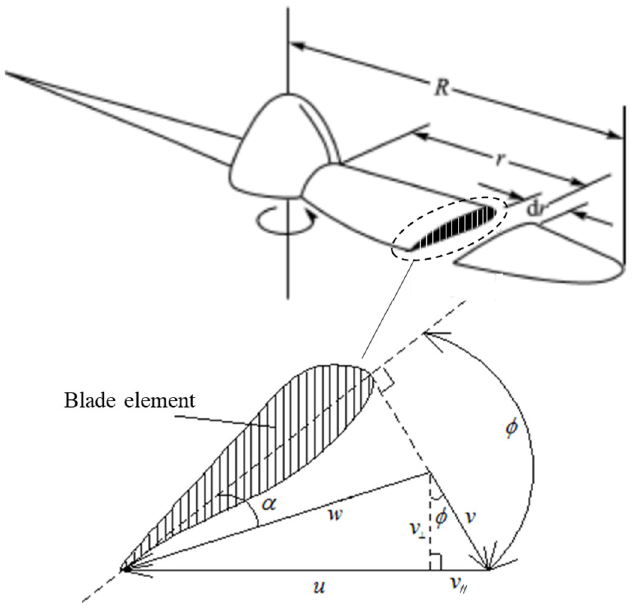
Figure 7. Relationship between rotor blade element velocity and angle of a tt ack.